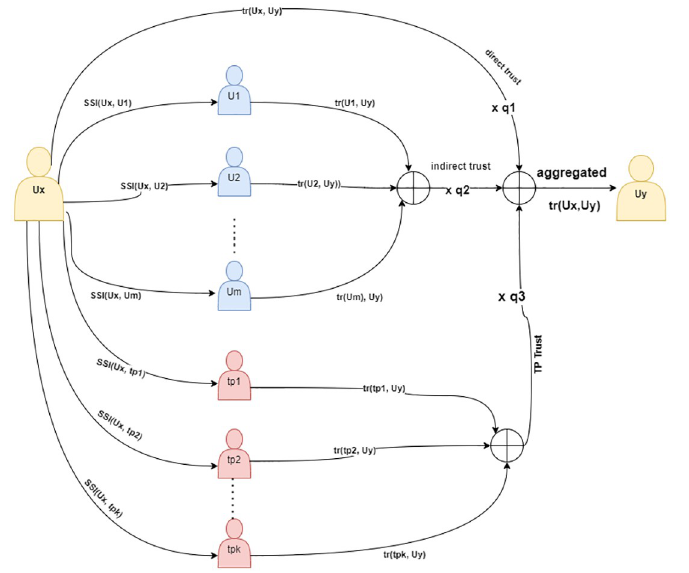
Fig 1. Visualization of the proposed aggregation of computed